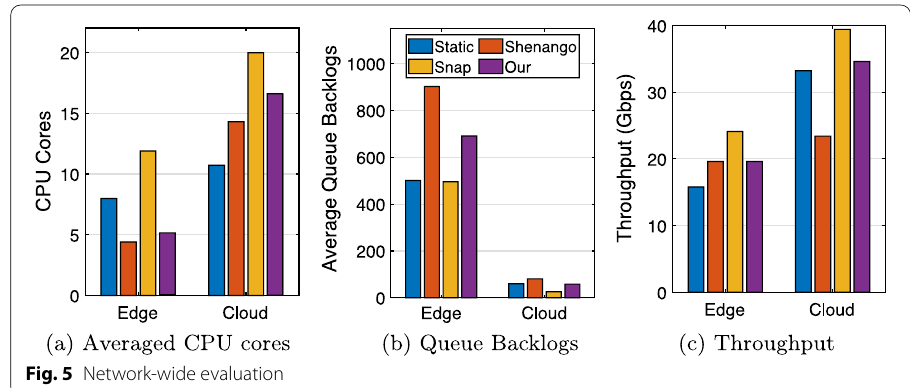
Fig. 5 Network-wide